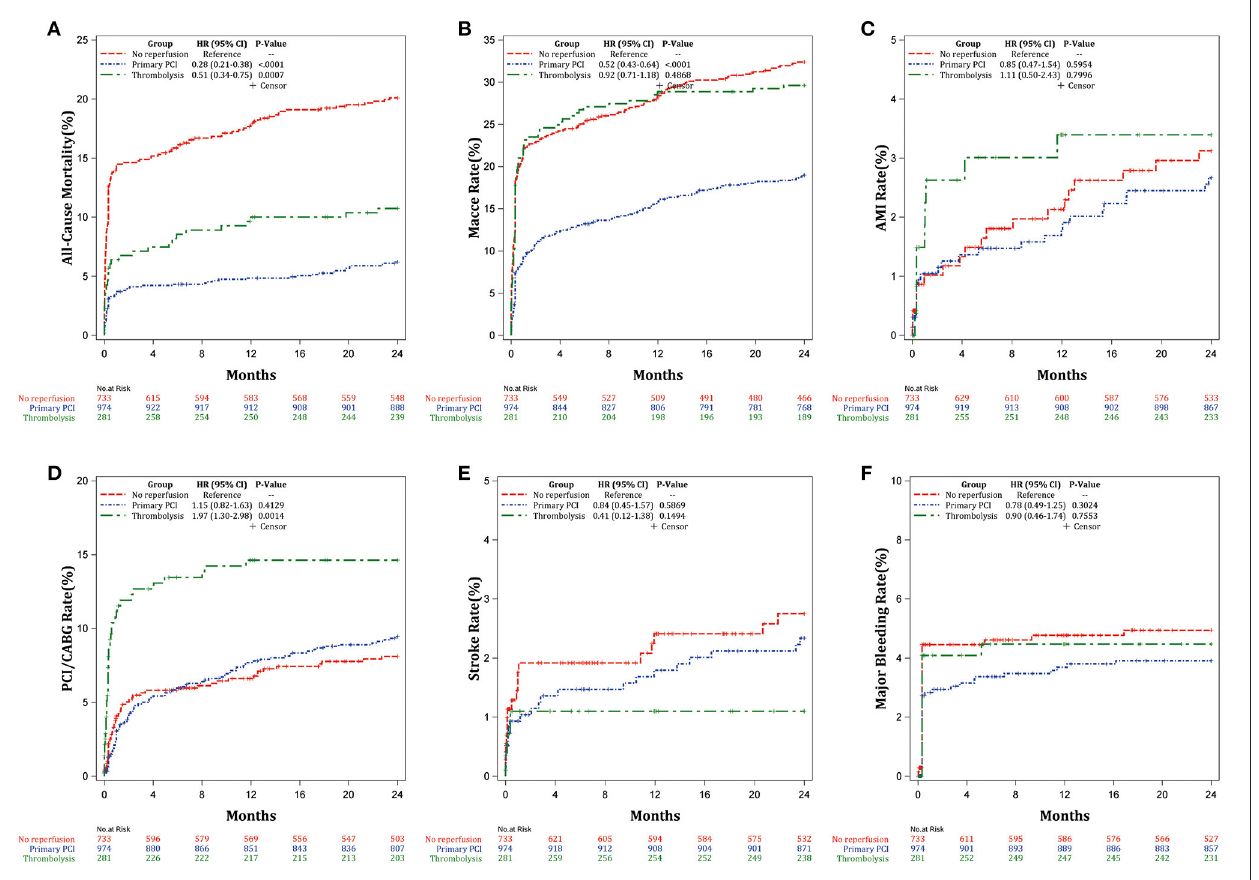
FIGURE 2 | Kaplan-Meier estimates of the cumulative incidence of the outcomes after 2-years follow-up. (A) All-cause mortality, (B) MACCE, (C) AMI, (D) Revascularization, (E) Stroke, and (F) Major